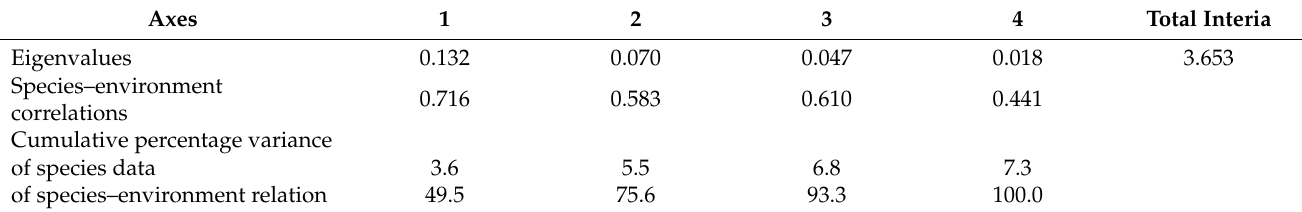
Table 5. Results of canonical correspondence analysis for species–environment